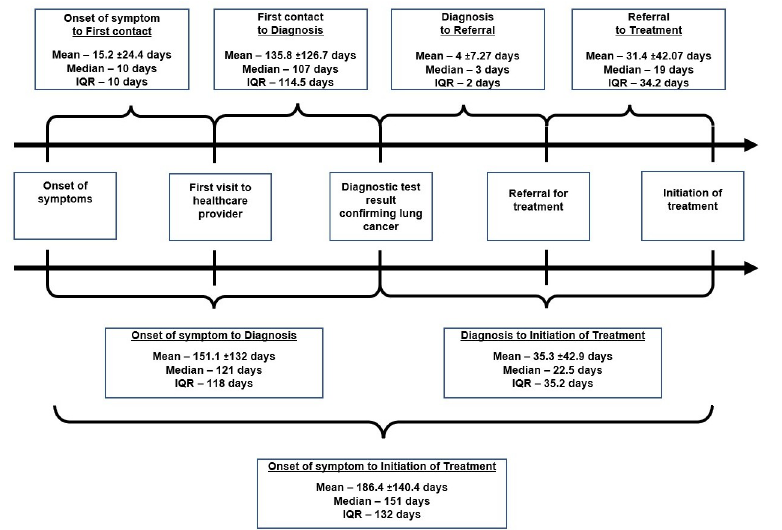
Fig 1. Timepoints and intervals in the care seeking pathway for lung